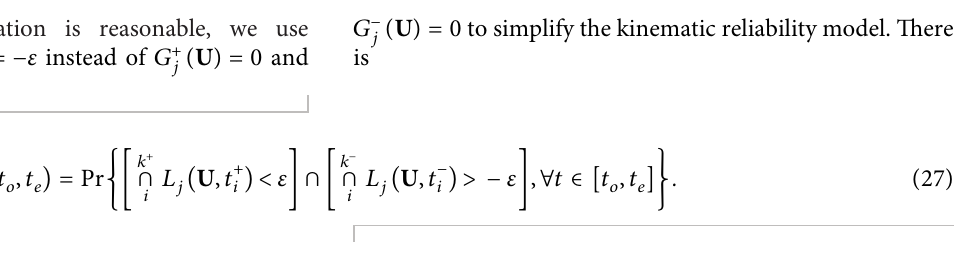
Figure 3: Intersections at instant time t +